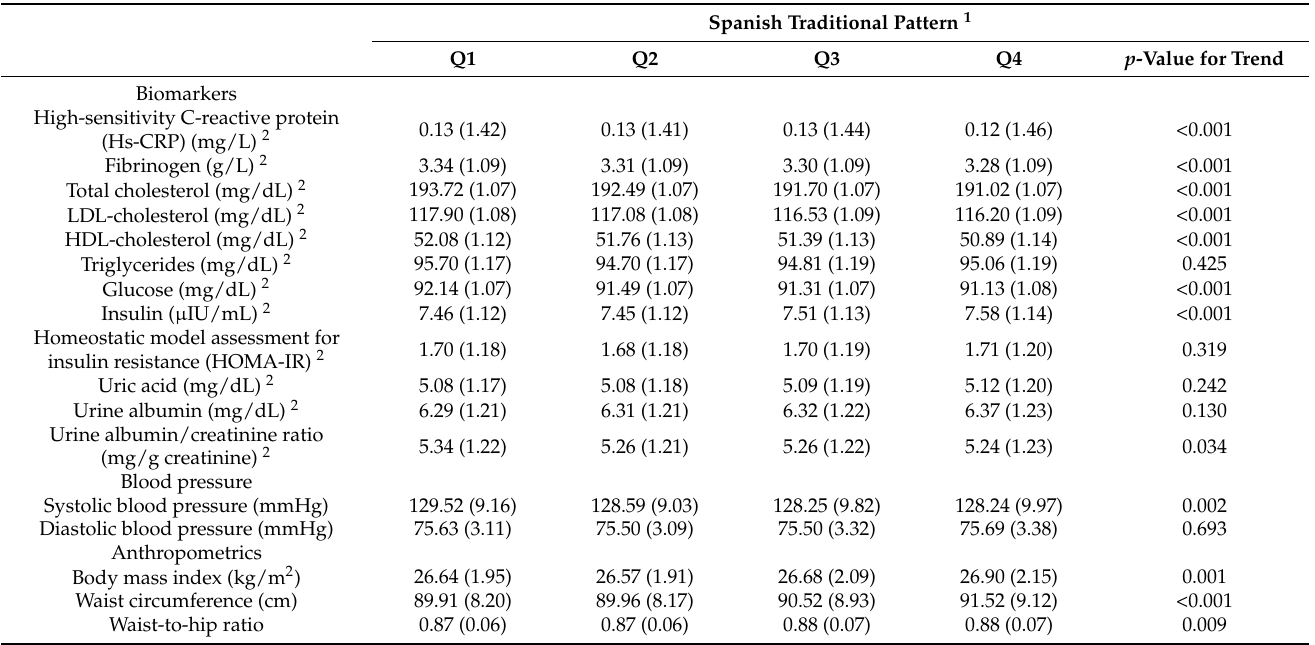
Table 3. Plasma and urine concentrations of inflammatory and cardio-metabolic biomarkers, blood pressure, and anthropo- metrics according to the quartiles of the Spanish traditional pattern.